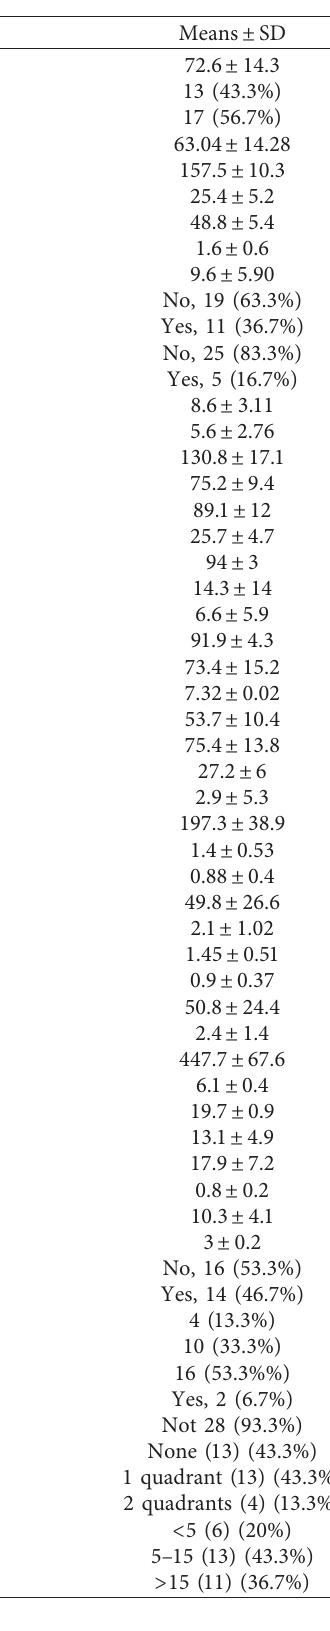
Table 1: Baseline characteristics of the study